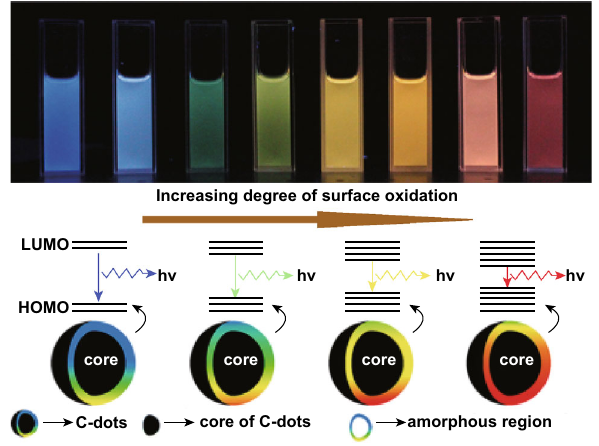
Fig. 10 a CD samples with increasing surface oxidation (from left to right) imaged under 365 nm UV light irradiation, and b model for the tunable PL of CDs with the increasing level of oxidation (from left to right) [93]. Copyright (cid:2) 2015 American Chemical